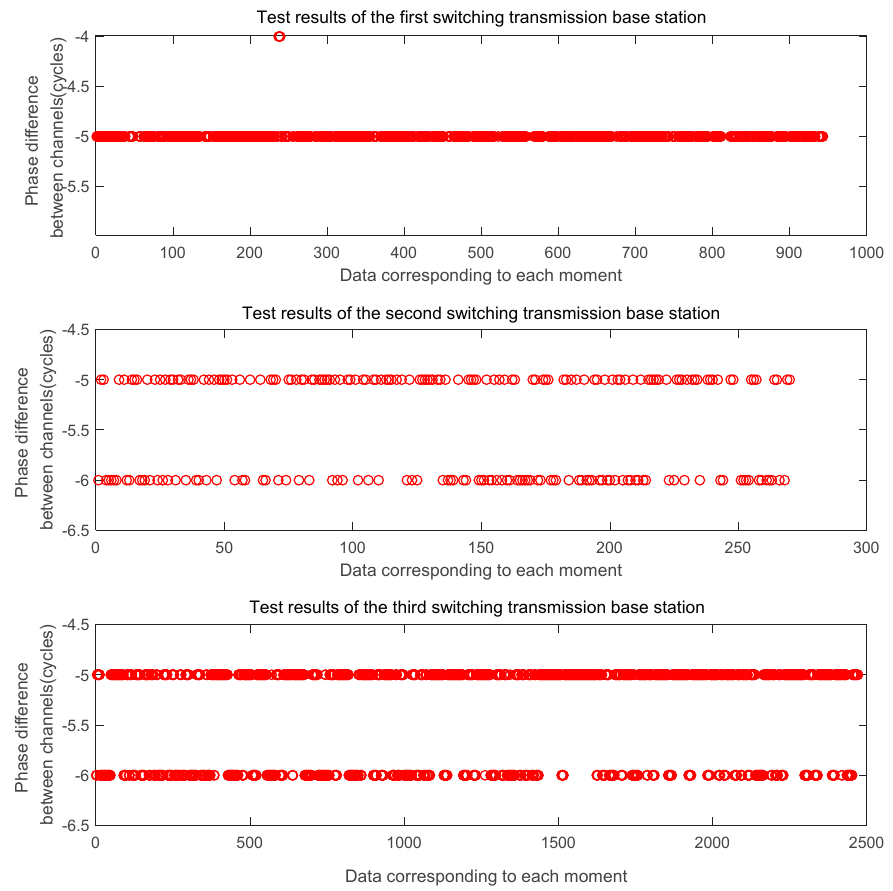
Figure 5. Test of influence of power on / o ff on B1 phase di ff erence results between channels.